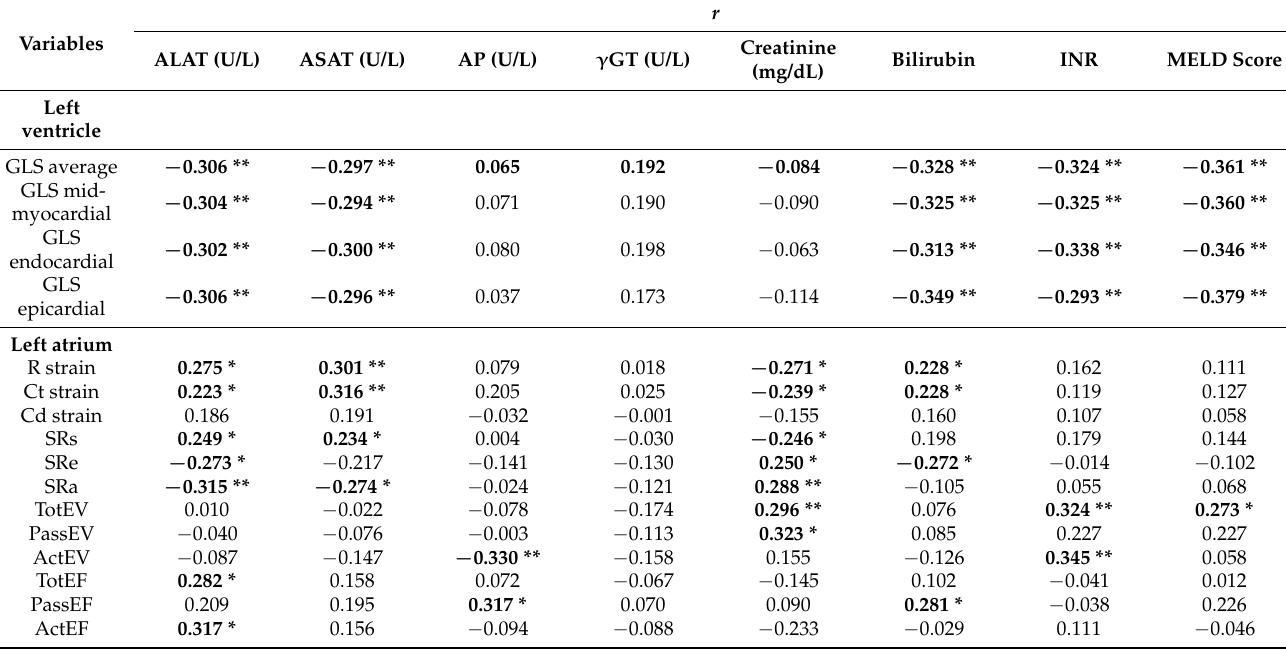
Table 5. Correlation analysis in ESLD patient